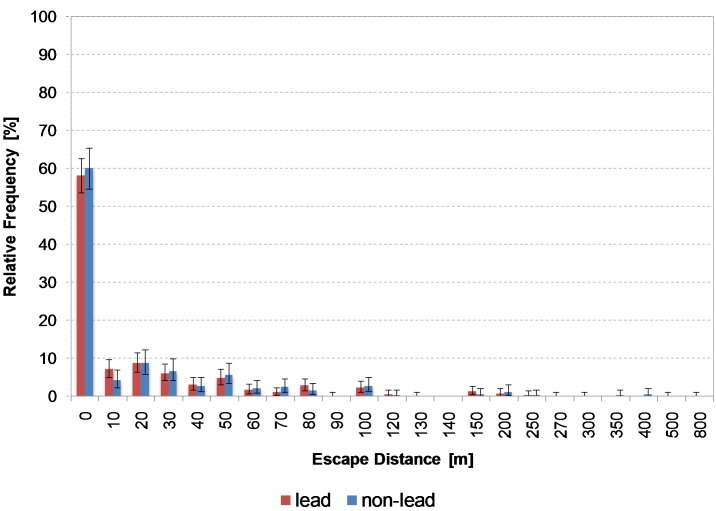
Distribution of escape distances of wild boar with 95% confidence interval.From escape distances above 100 m, the spacings on the horizontal x axis are no longer divided into classes of 10 m. Reports of escape distances above 100 m were rare. Escape distances of 0 m also contains distances from 1 to 9 m.